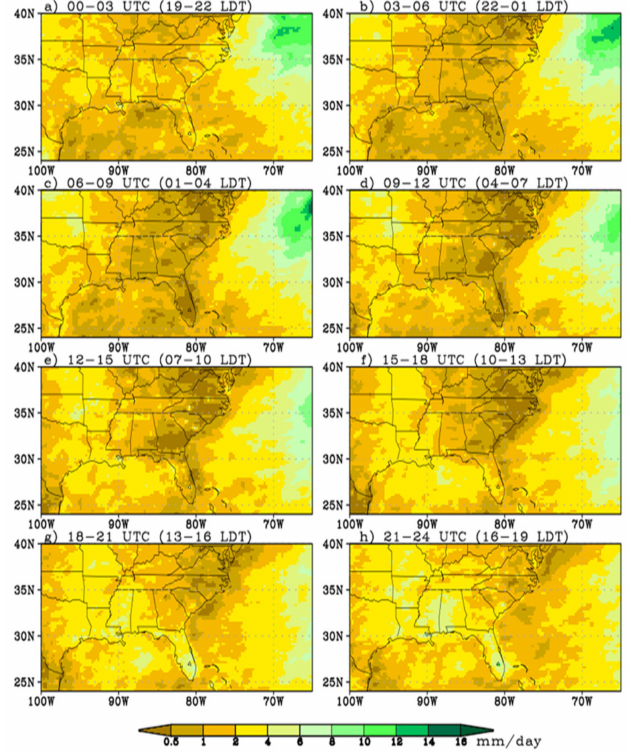
Figure 8. Same as Figure 7, but for